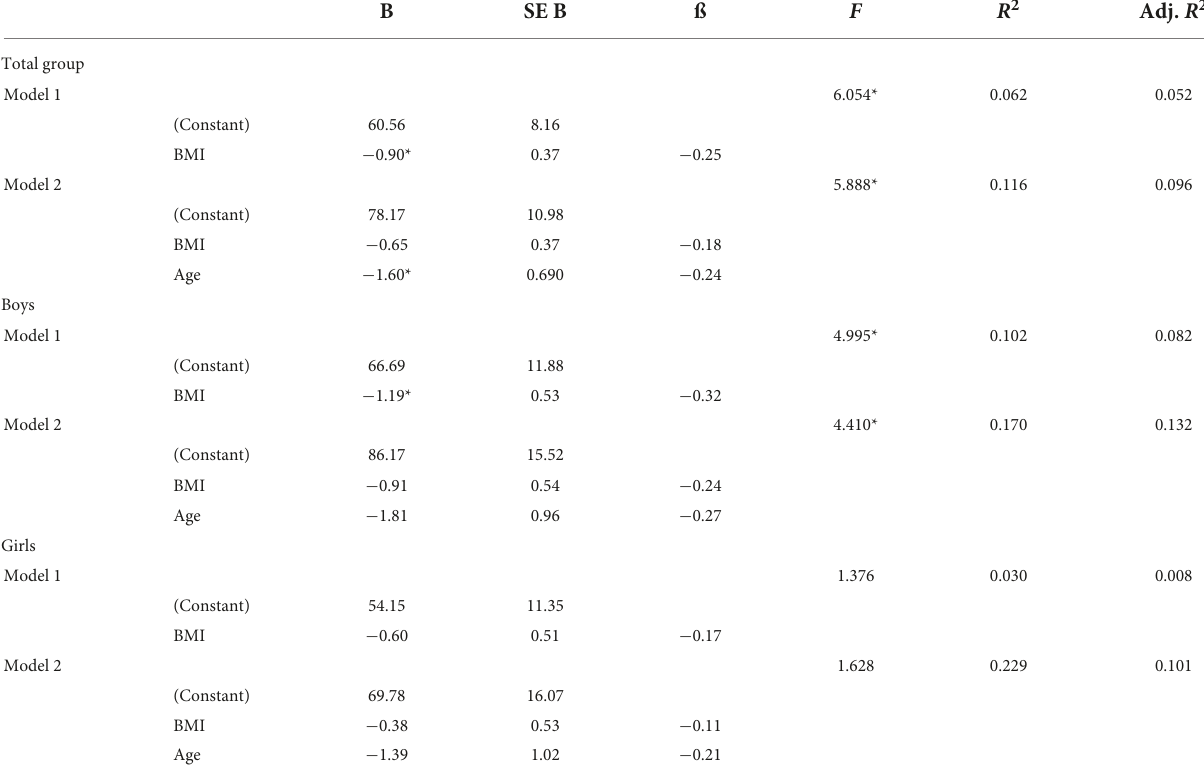
TABLE 3 Multiple regression results for Vitamin D3 level for boys and girls